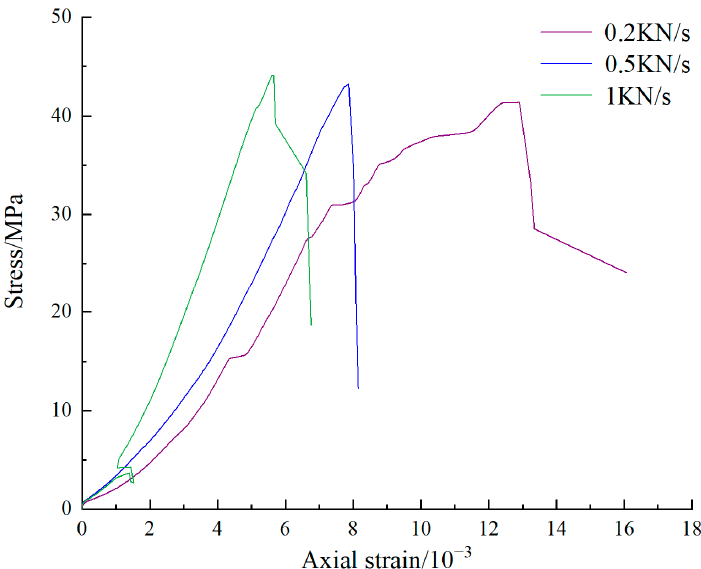
Figure 4. Stress-strain curve under uniaxial compression.